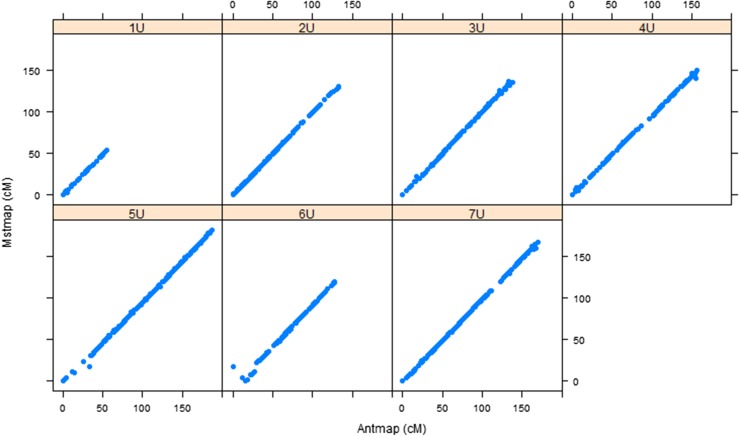
Comparison of linkage maps constructed with MSTMap and Antmap algorithms for Aeupop2. The x-axis indicates the genetic distance (centimorgan) based on Antmap software, whereas the y-axis indicates the genetic distance (centimorgan) based on MSTMap software for each chromosome.